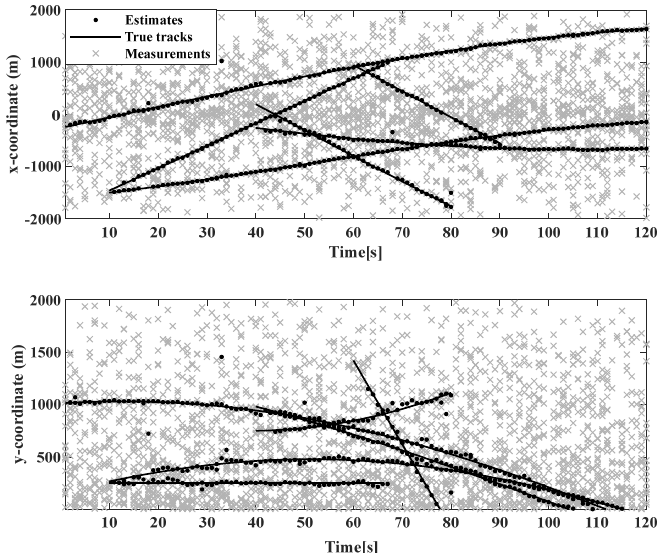
Figure 10. Real trajectories, measurements, and estimates in Cartesian coordinates in nonlinear models. Table 3. Initial state of nonlinear Gaussian measurement model target.